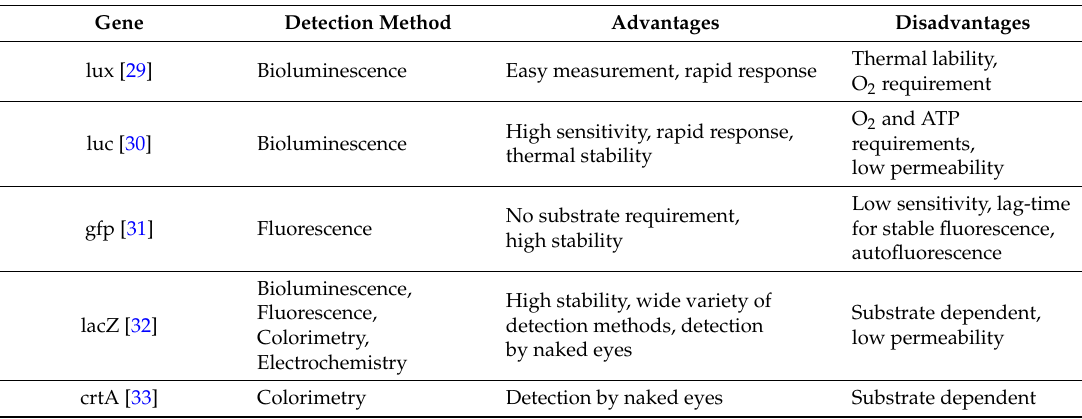
Table 1. A summary of typical reporter genes used in whole cell-based